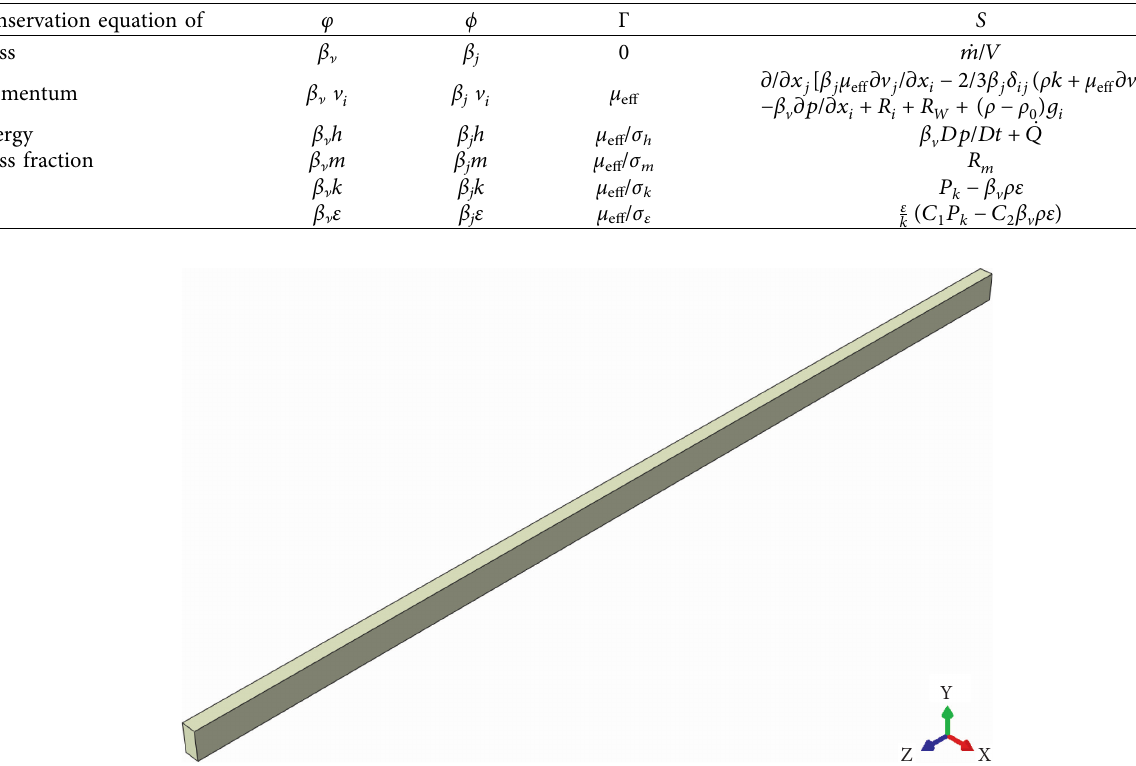
Figure 2: Finite element